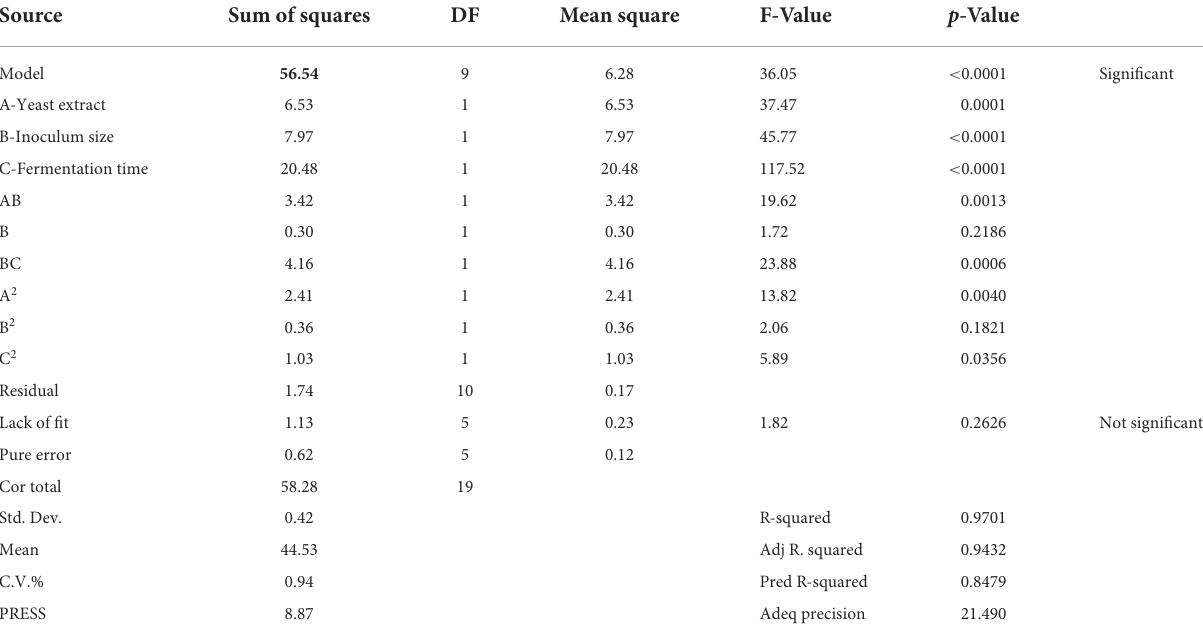
TABLE 4 ANOVA analysis for response surface quadratic model for biosurfactant production in terms of surface tension measurement (mN/m). Source Sum of squares DF Mean square F-Value p -Value